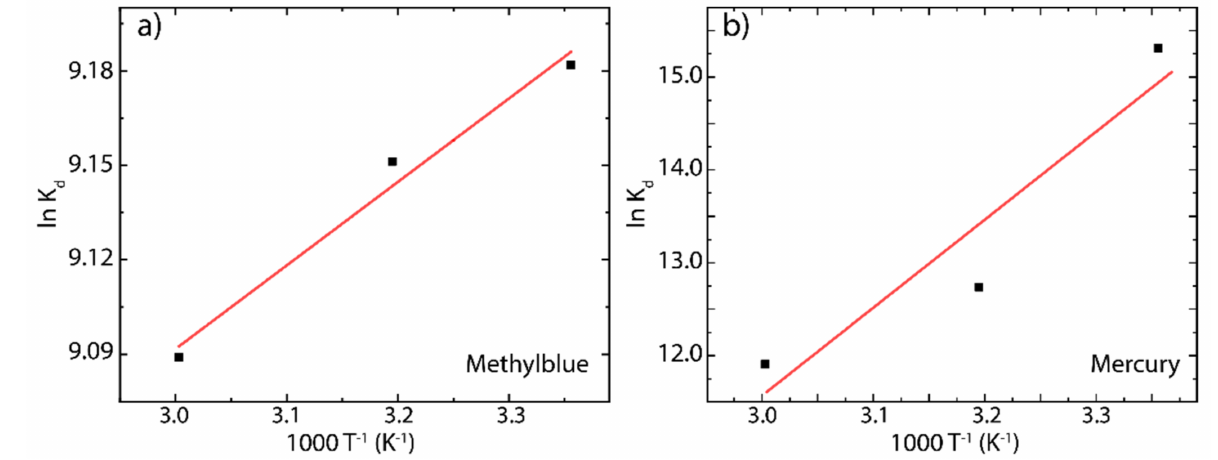
Figure 11. Van’t Hoff study for the adsorption of ( a ) MB on rGO and ( b ) Hg(II) on rGO. Table 5. Thermodynamics parameters for Mb and Hg(II) adsorption on rGO at three different temperatures. T